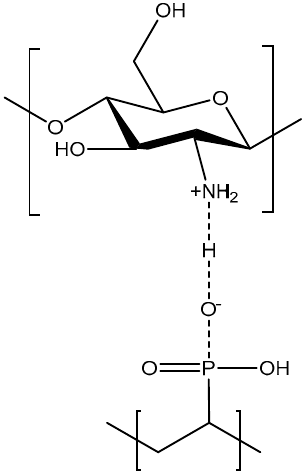
Figure 9. Schematic indicating acid-base pairing between chitosan and VPA monomer units.